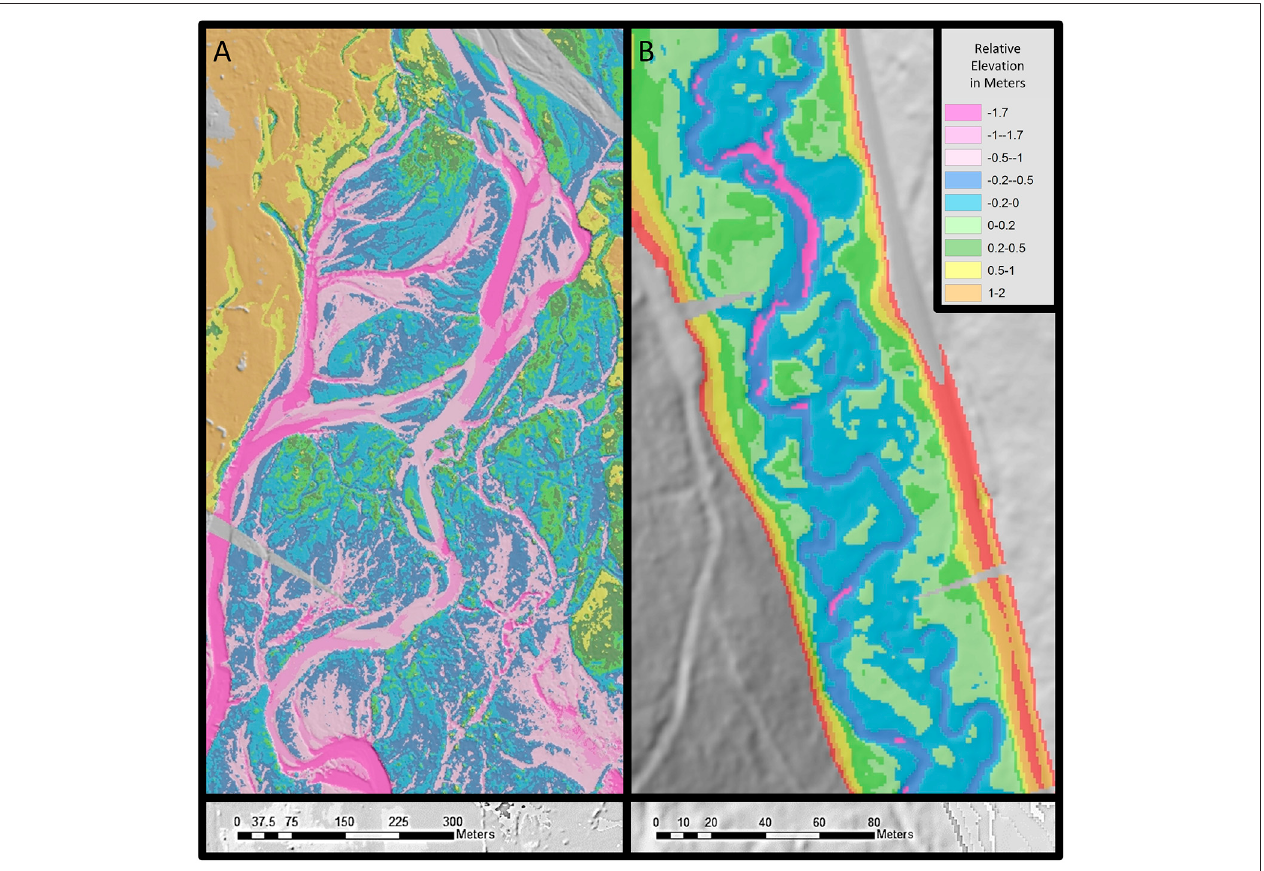
FIGURE 3 | Complex, multi-threaded channel planforms can develop in relatively large and small river-wetland corridors: (A) Methow River, Washington, United States; (B) Summit Creek, Oregon, United States.